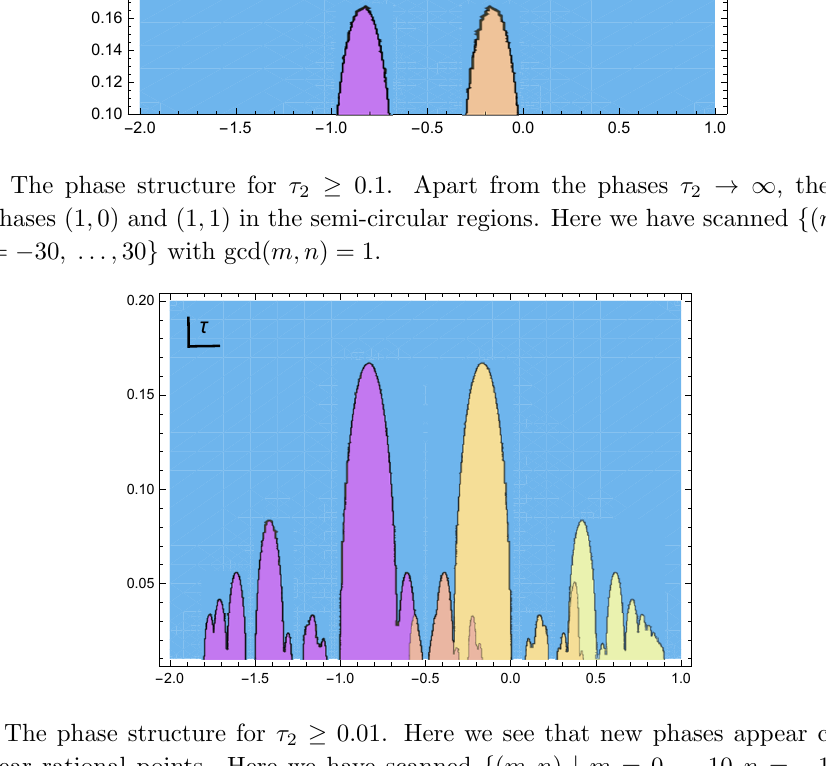
Figure 8 . The phase structure for (cid:28) 2 (cid:21) 0 : 01. Here we see that new phases appear close to the real axis, near rational points. Here we have scanned f ( m; n ) j m = 0 ; : : : 10 ; n = (cid:0) 10 ; : : : ; 10 g with gcd( m; n ) =